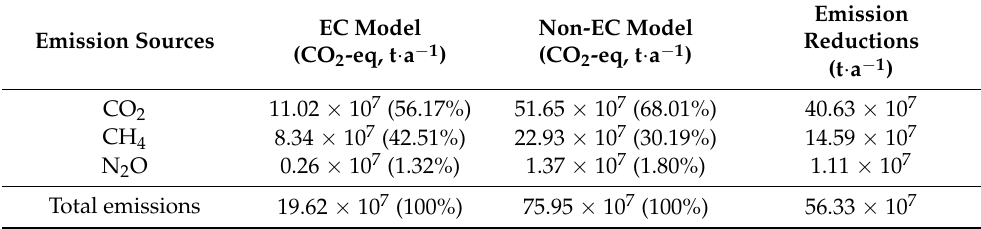
Table 3. Proportions of different types of GHG